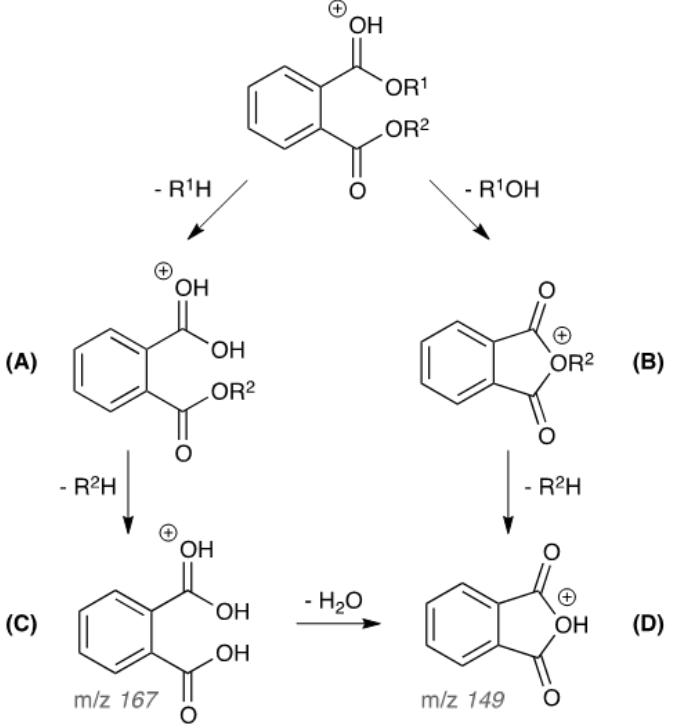
Figure 2. The proposed CID fragmentation pathway of phthalates by APGC-MS/MS under wet con- ditions.